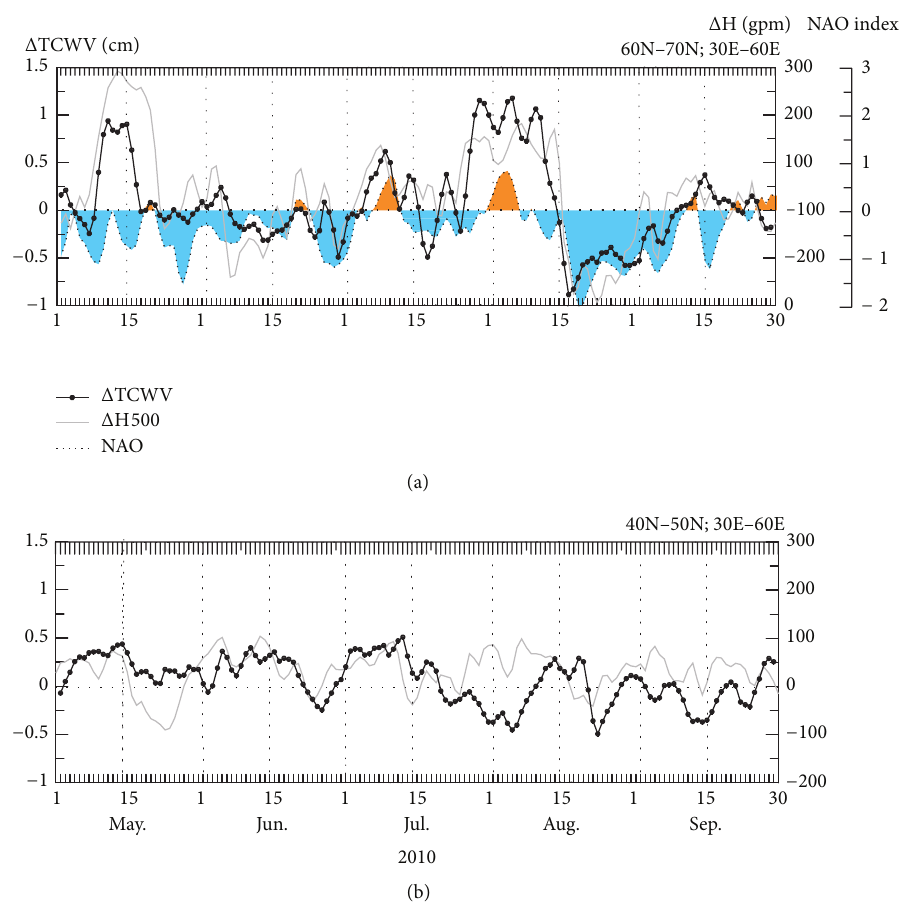
Figure 3: Daily anomalies of TCWV and 500 hPa height averaged over the territories restricted by the coordinates 60 ∘ –70 ∘ N; 30 ∘ –60 ∘ E (a) and 40 ∘ –50 ∘ N; 30 ∘ –60 ∘ E (b). For each day the anomalies were calculated as difference between daily average in 2010 and average for this day in 2000–2009. In (a) the daily normalized NAO index is also depicted.